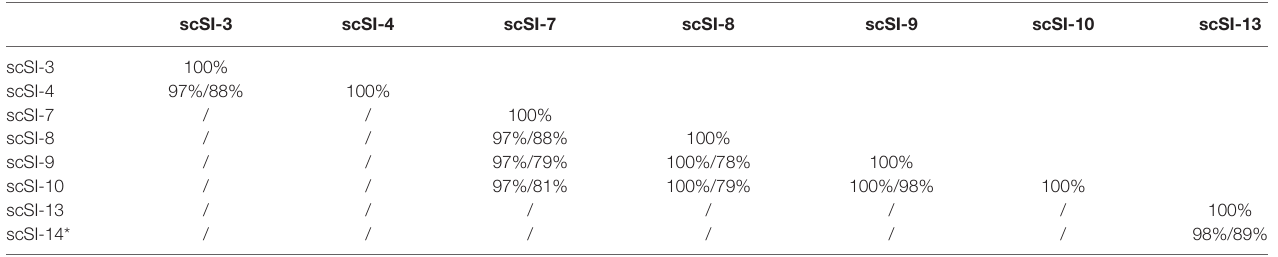
TABLE 2 | Coverage and similarity among peptide sequences of Family I84